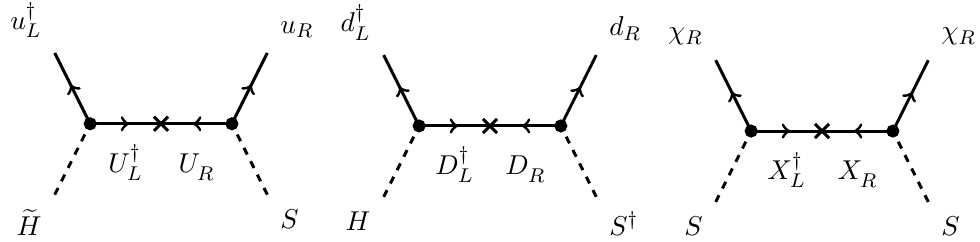
Figure 5. Generating the dimension-5 Yukawa interactions via vector-like-fermions. The fermion flow reflects the fact that we work with (0 , 1 ) -representation fermions, see [50]. The diagram for 2 the electron is omitted but it can be obtained from the down-quark one by the replacement d → e and D → E . The vector-like fermions, U, D, E, X are neutral under U (1) 0